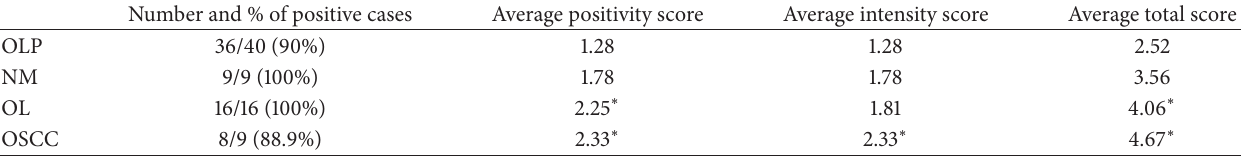
Table 4: Percentage of positive cases and average positivity, intensity, and total scores for phospho-pS6 per lesion category.